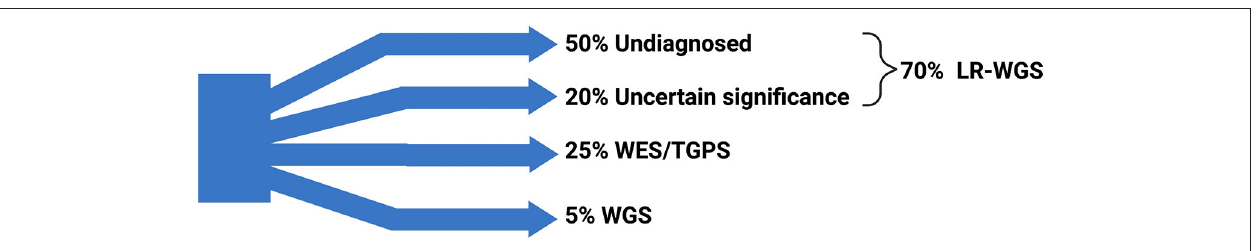
FIGURE 2 | Traditional genetic workup and possibilities derived from long-read sequencing. The traditional (current) genetic workup is not diagnostic in about 50% of cases; other 20% of unresolved cases are represented by variants of uncertain significance. LRS (when coupled with whole genome sequencing— WGS, namely LR-WGS) has the potential to diagnose up to 70% of currently unresolved cases. The remaining 25% of cases are diagnosed using targeted genetic panel sequencing (TGPS) and whole exome sequencing (WES), and 5% of cases are diagnosed by WGS. Data derived from Salinas et al. (104) and Frésard et al. (119). Created with